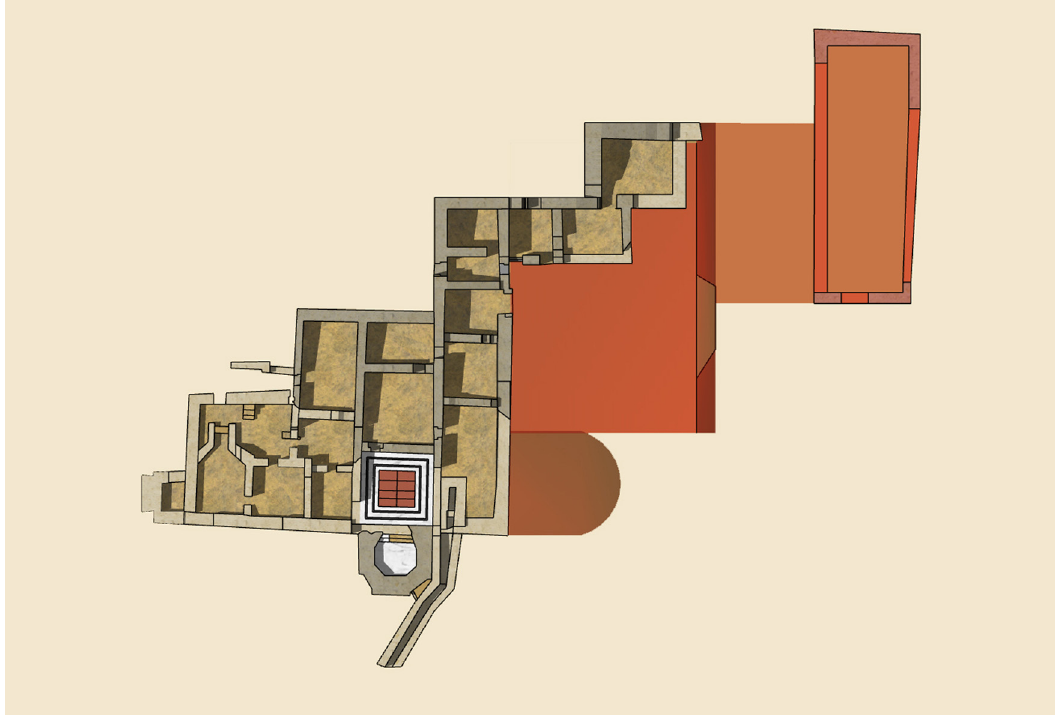
Figure 13: A plan of new areas marked in red as hypothesised from the newly recovered structures and GPR survey ( Source: Author )